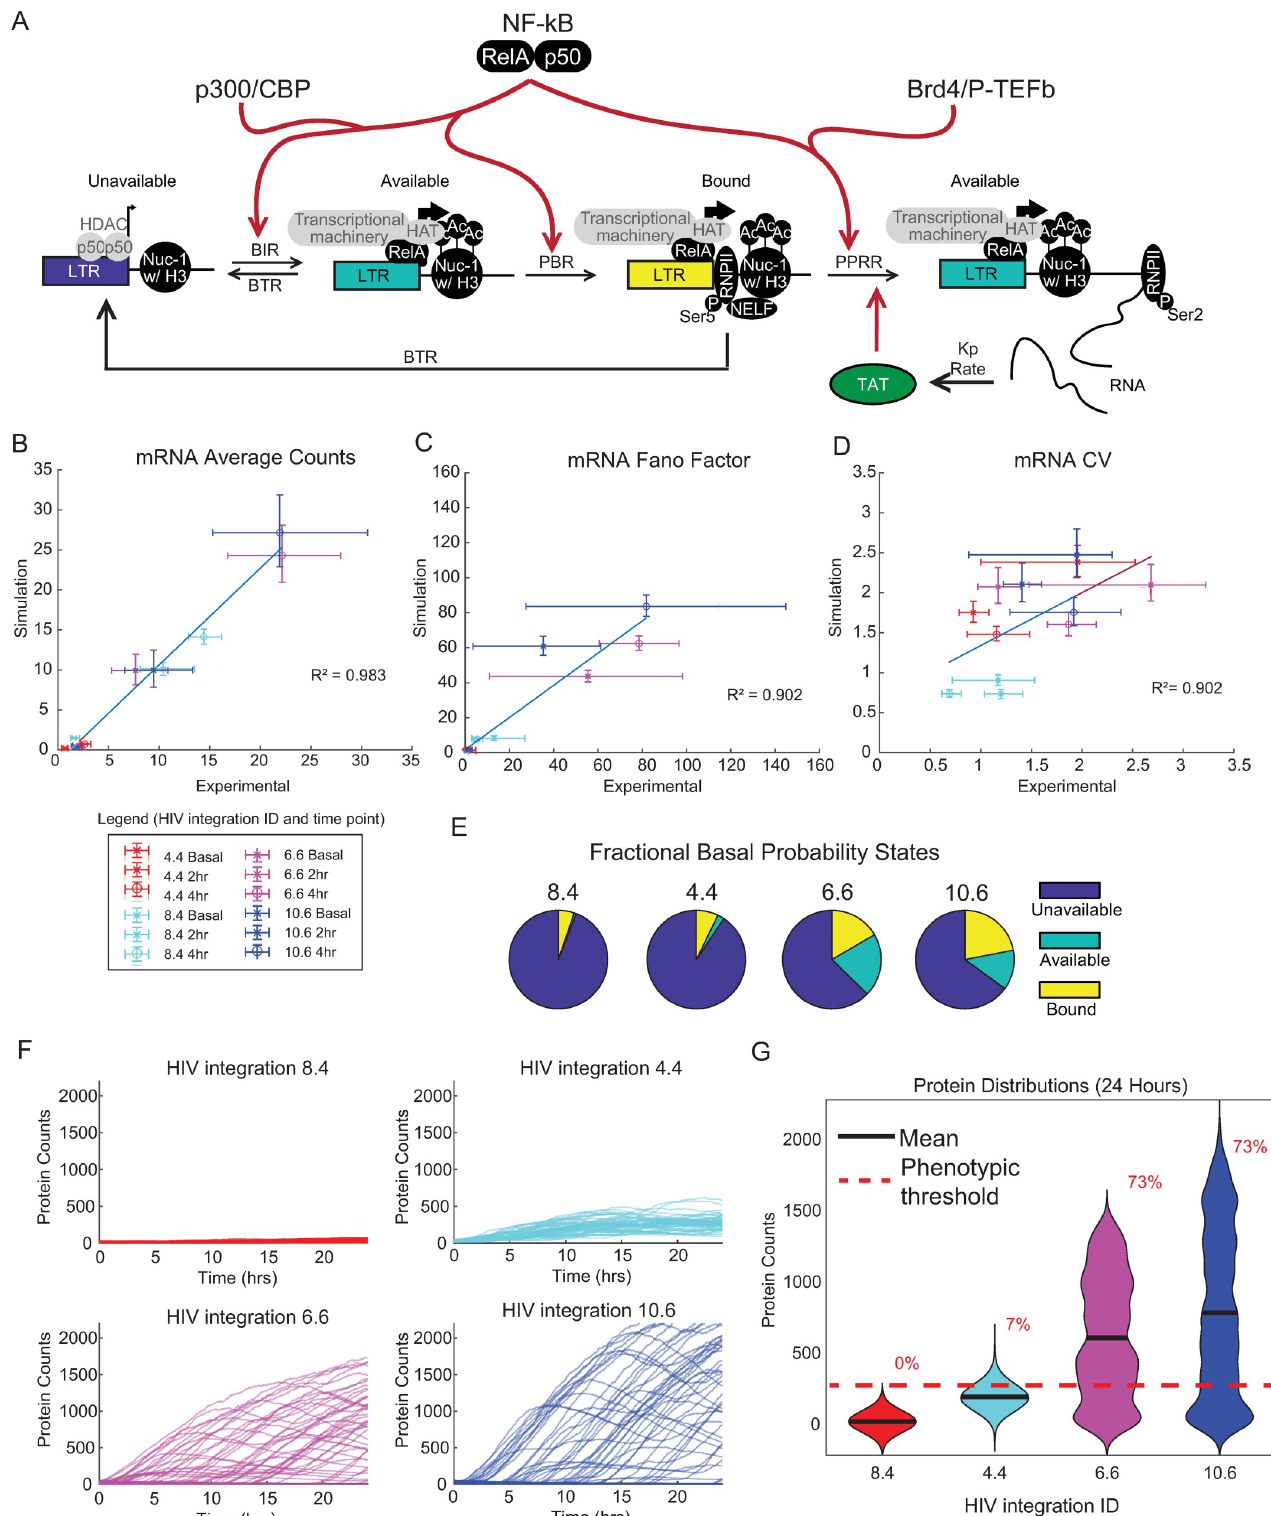
Fig 6. Implementing transcriptional activation via increases in multiple parameters reproduces transcriptional activation heterogeneity observed for a range of latent HIV integrations with more biological accuracy. (A) Schematic of multi-point three-pronged activation in the transcriptional cycling model